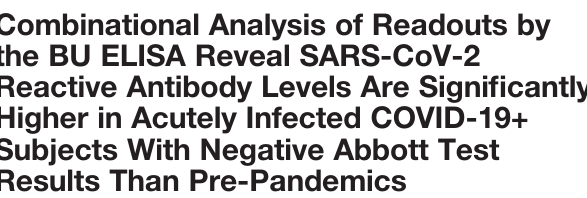
( Figure 5C ). The AU values for six Abbott test negative subjects were above the pre-pandemic range for RBD-speci fi c IgM and for N-speci fi c IgA, and two Abbott test negative subjects have RBD- speci fi c IgG above the pre-pandemic range ( Figure 5C ), Taken together, these iresults show clear serological evidence of infection in many of these Abbot test- subjects.